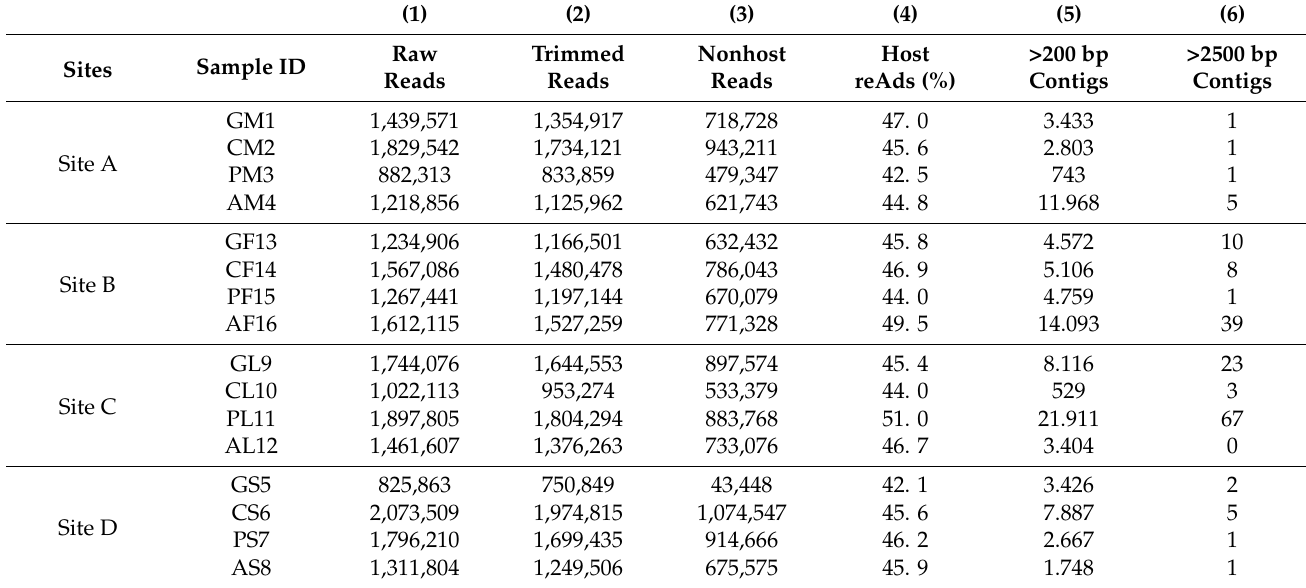
Table 1. Summary statistics of (1) raw sequence read pairs, (2) trimming, (3, 4) host mapping and (5, 6) contig